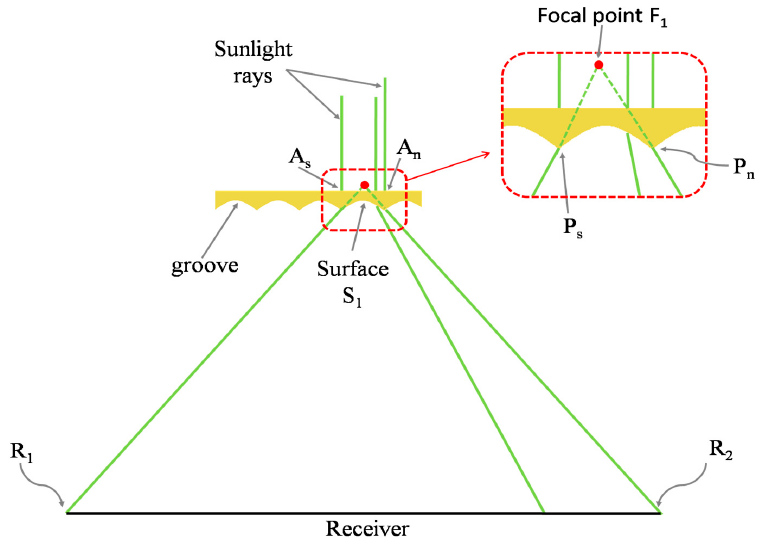
Figure 8. The sunlight distribution by the divergence linear Fresnel lens.